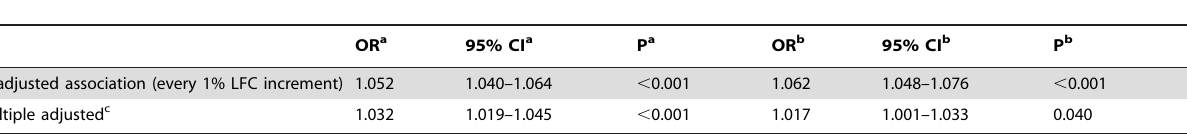
Table 2. Association between the liver fat content and prediabetes and diabetes.